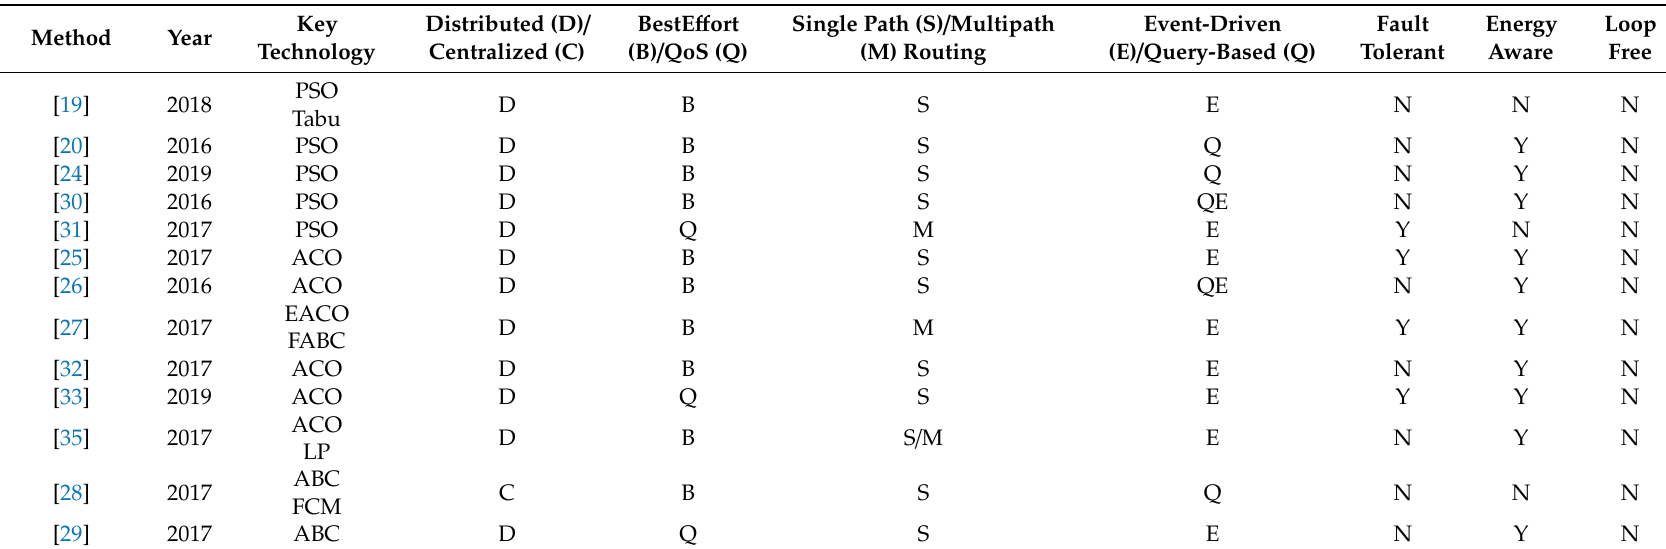
Table 4. Routing algorithms of WSN routing protocol based on